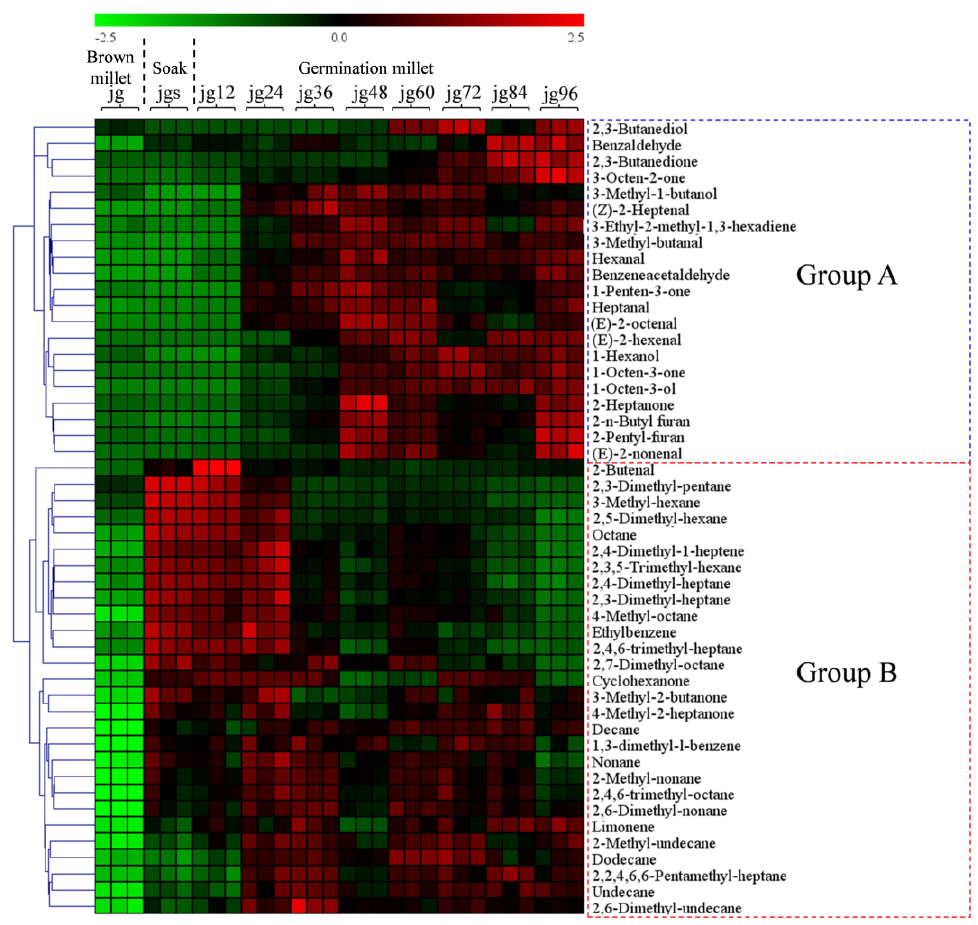
Figure 2. A heatmap of the contents of volatiles during germination of foxtail millet. The data were auto-scaled and clustered according to the Pearson correlation coefficients. Green colors indicated that the volatile level was less than its mean level during millet germination, while red colors indicated that the volatile level was higher than its mean level. Group A mainly contained ketones, aldehydes, alcohols, and furans, whereas group B mainly contained alkanes and alkenes. jg, jgs, and jg12–96 represented the raw brown millet, soaked brown millet, and germinated millet, respectively.